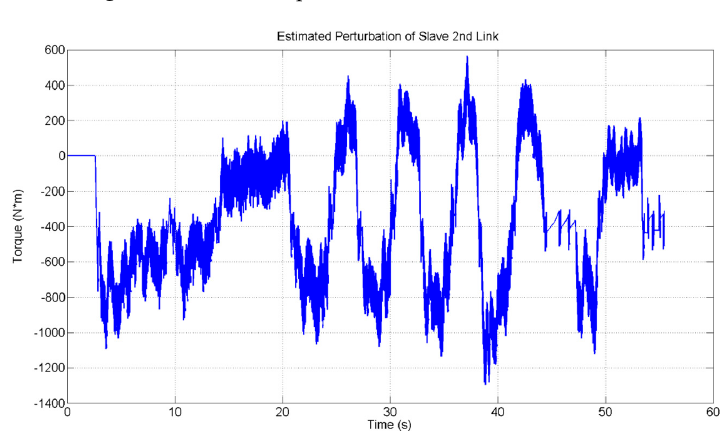
Figure 18. Estimated perturbation of master for 2nd link.